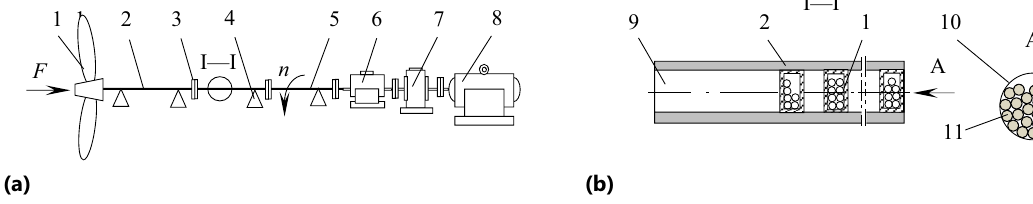
Figure 1. Schematic diagram of underwater vehicle shafting: (a) Test device; (b) Particle damper. 1—propeller; 2—propeller shaft; 3—connecting flange; 4—bearing; 5—thrust bearing; 6—reducer; 7—drive motor; 8— lightening hole; 9—particle damper; 10—damper cavity;